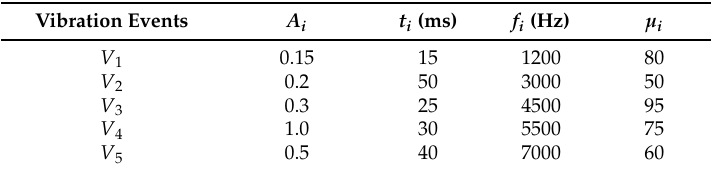
Table 1. The parameter of each vibration